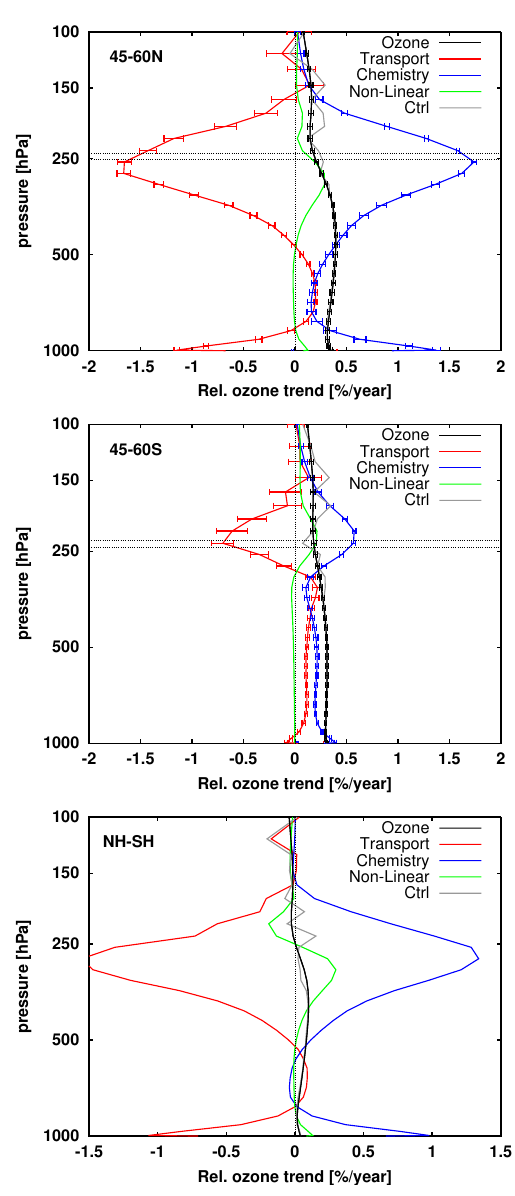
Fig. 8. Profile of relative trends in ozone (in units of % per year) from E39CA over the period 1960 to 2049 (black). Chemically- and transport-induced trends in ozone are shown in blue and red, the nonlinear term in green and the sum of these three in grey (“Ctrl”). The black dashed horizontal lines indicate the mean tropopause height in the 1960s (lower line) and 2040s (upper line). Top panel: 45 to 60 ◦ N, middle: 45 to 60 ◦ S, bottom: NH −